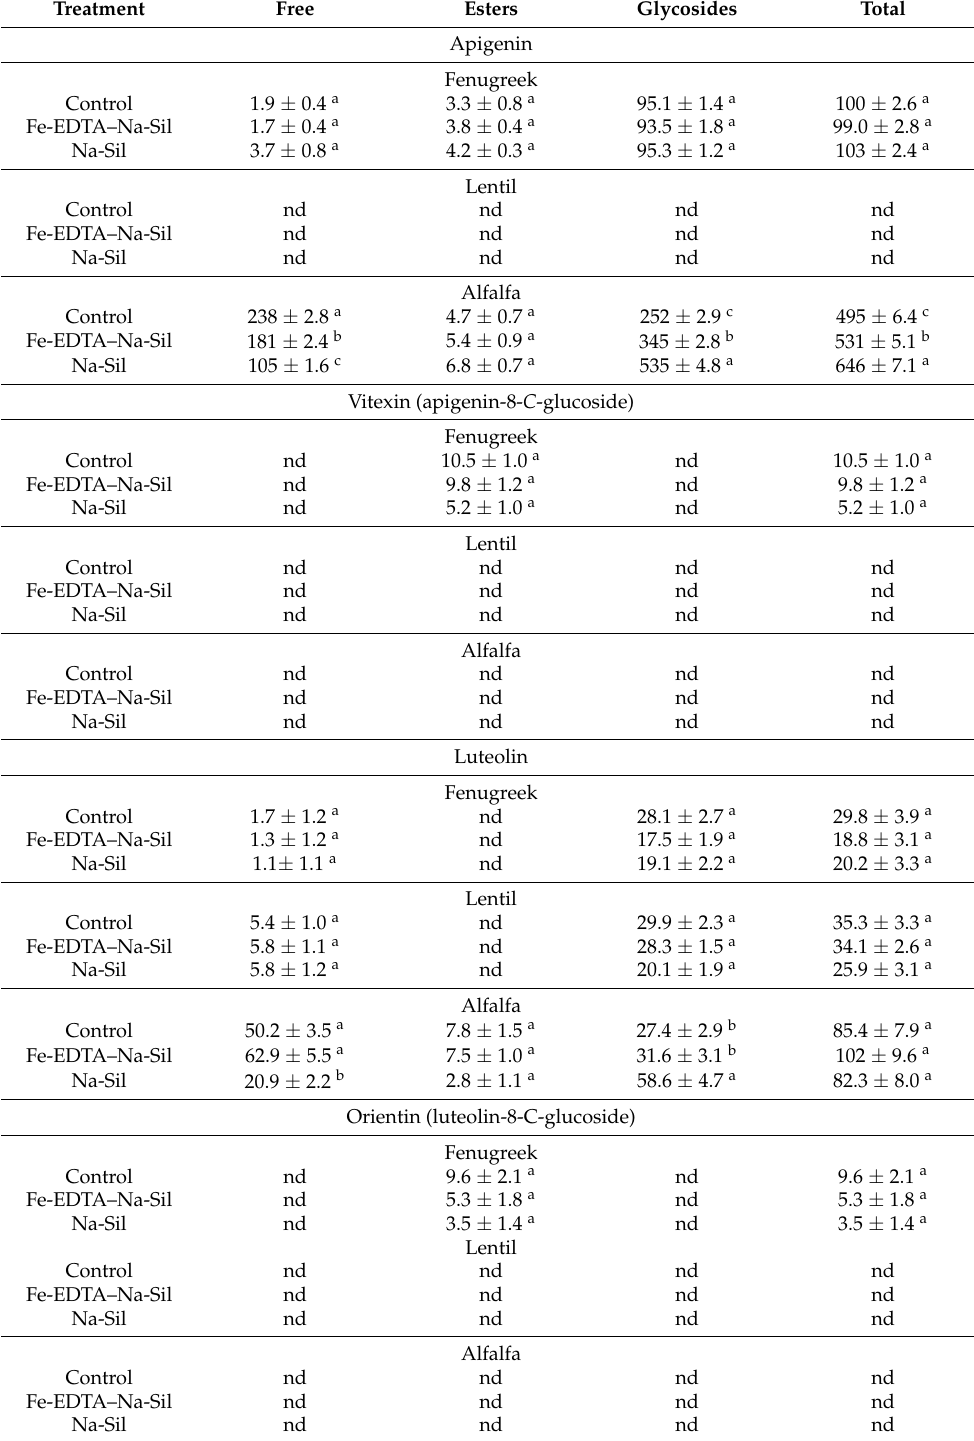
Table 3. The contents of flavones (free and released from ester and O -glycoside forms) in legume sprouts ( µ g/g DW) treated with elicitors during